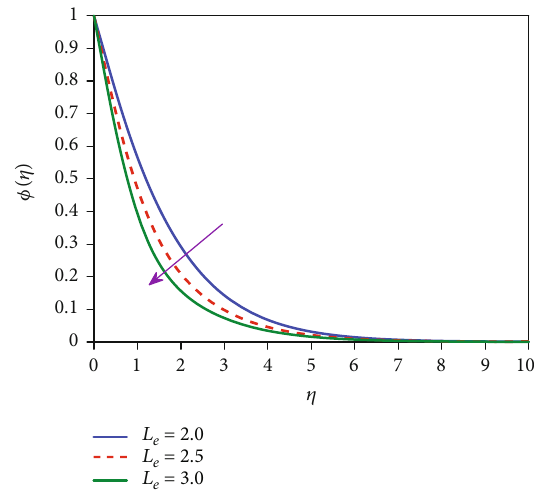
Figure 29: E ff ect of Le on the concentration ϕ ð η Þ